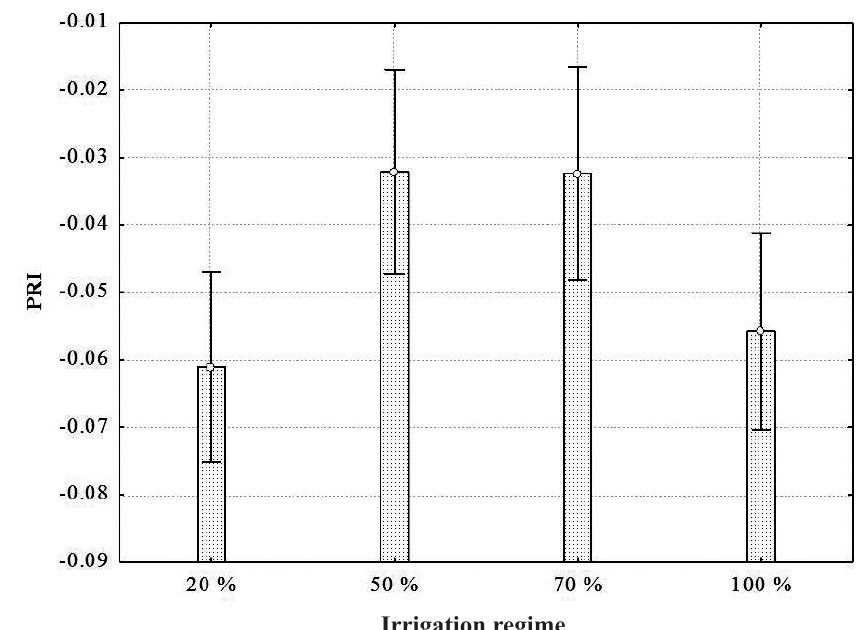
Figure 4. Mean photochemical reflective index (PRI) values as measured on 12 May 2006 for potted grapevines receiv- ing 20%, 50%, 70% and optimal (100%) irrigation. Vertical bars denote confidence intervals at P= 0.05. Table 3. Mean intercept (A), slope (B) and R 2 -values of equations ( y =a x + b) following linear regression analysis of mean lesion length of the stem xylem and the pruning wound pith recorded in potted grapevines subjected to control treatment or inoculated with Neofusicoccum australe , N. parvum , Lasiodiplodia theobromae or Diplodia seriata over the 20, 50, 70% or optimal (100%) irrigation regimes . Intercept a Slope Treatment R 2 -value A